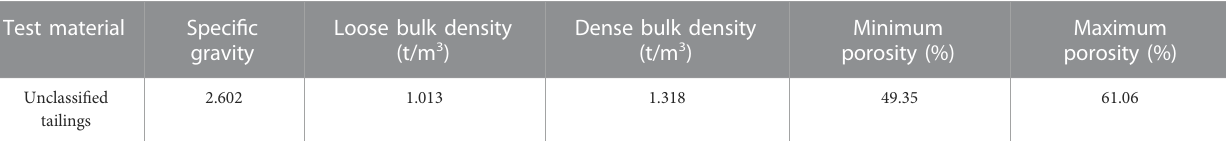
TABLE 1 Determination values of tailings physical property indexes.